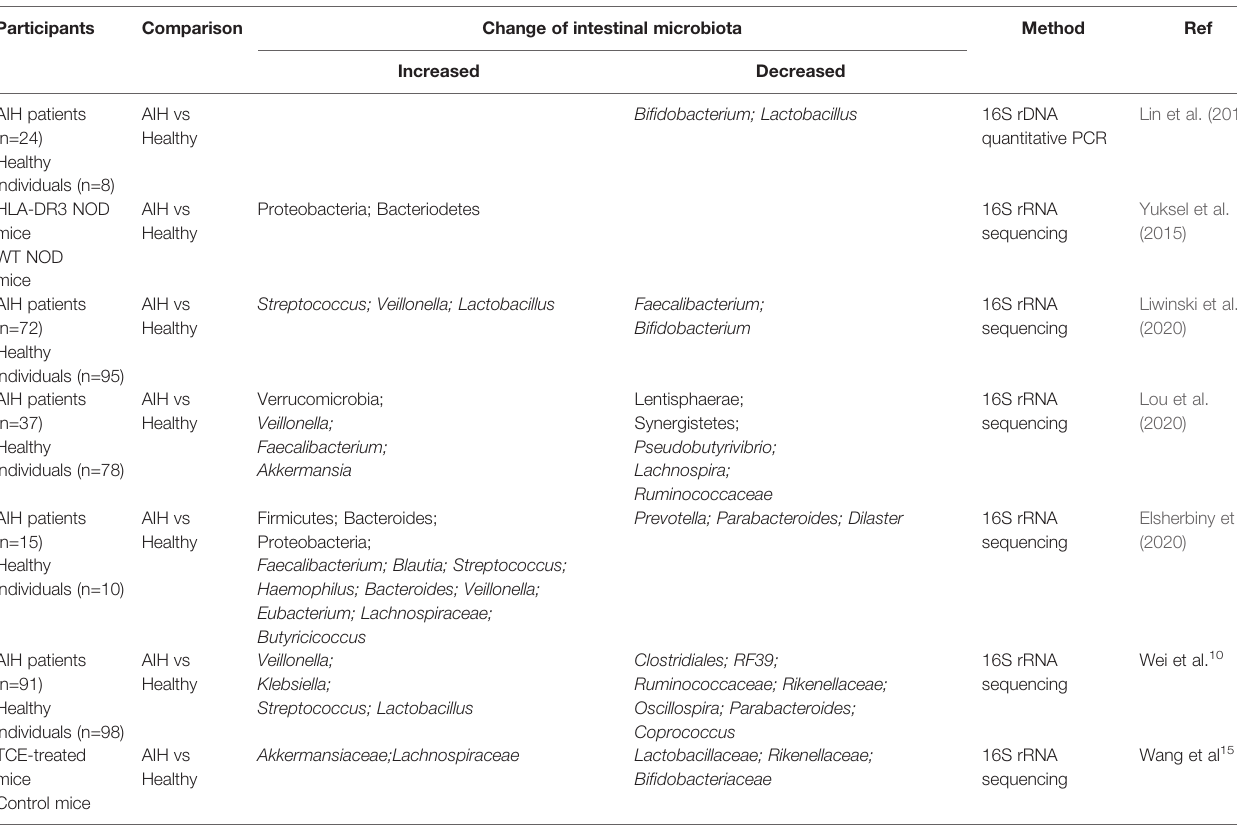
TABLE 1 | Changes of intestinal microbiota associated with AIH in